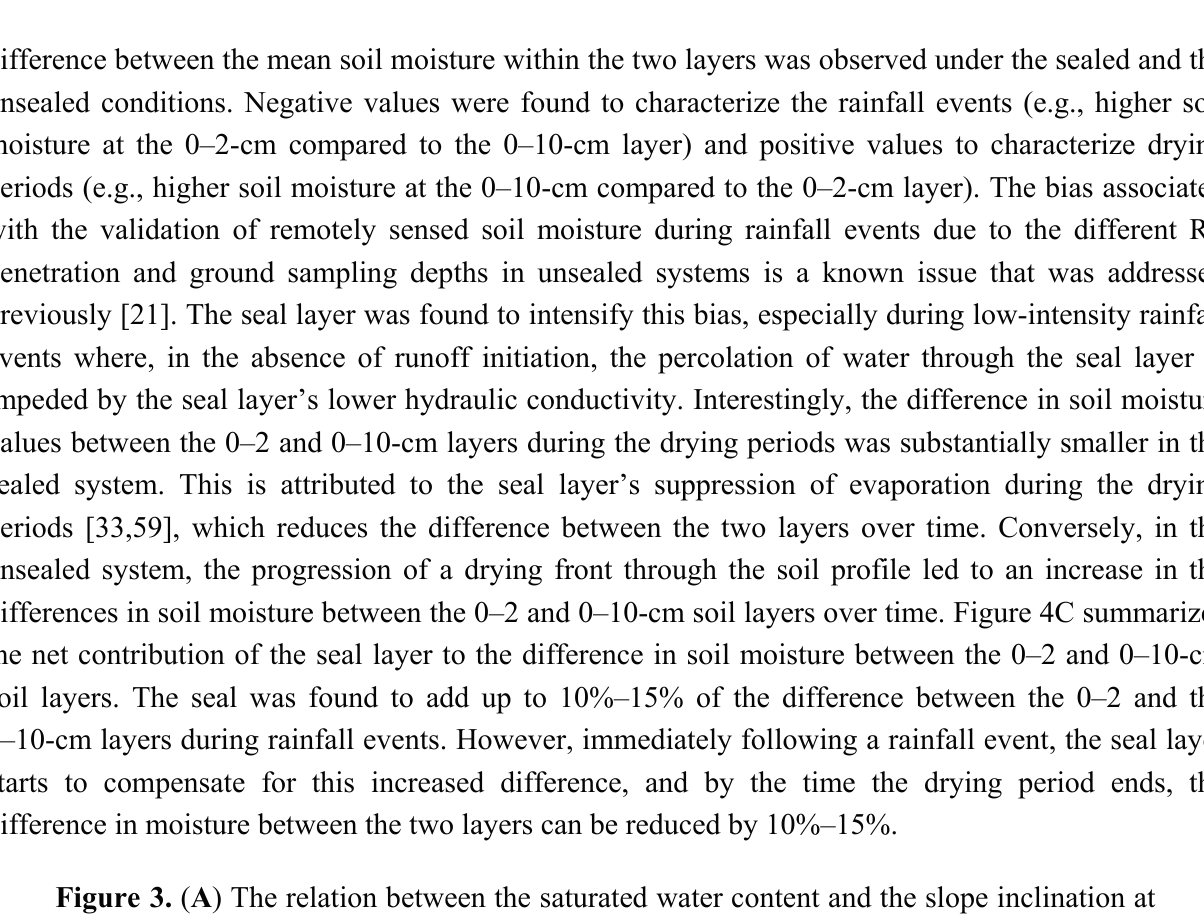
Figure 3. ( A ) The relation between the saturated water content and the slope inclination at the study site, calculated for the 30-m cells ( (cid:2009) = 0.05, (cid:2025) < 0.001 ). ( B ) The relation between the Diff value in each cell for Equations (4) and (5) and the saturated water content value (the sealed and unsealed systems are marked in blue and red,